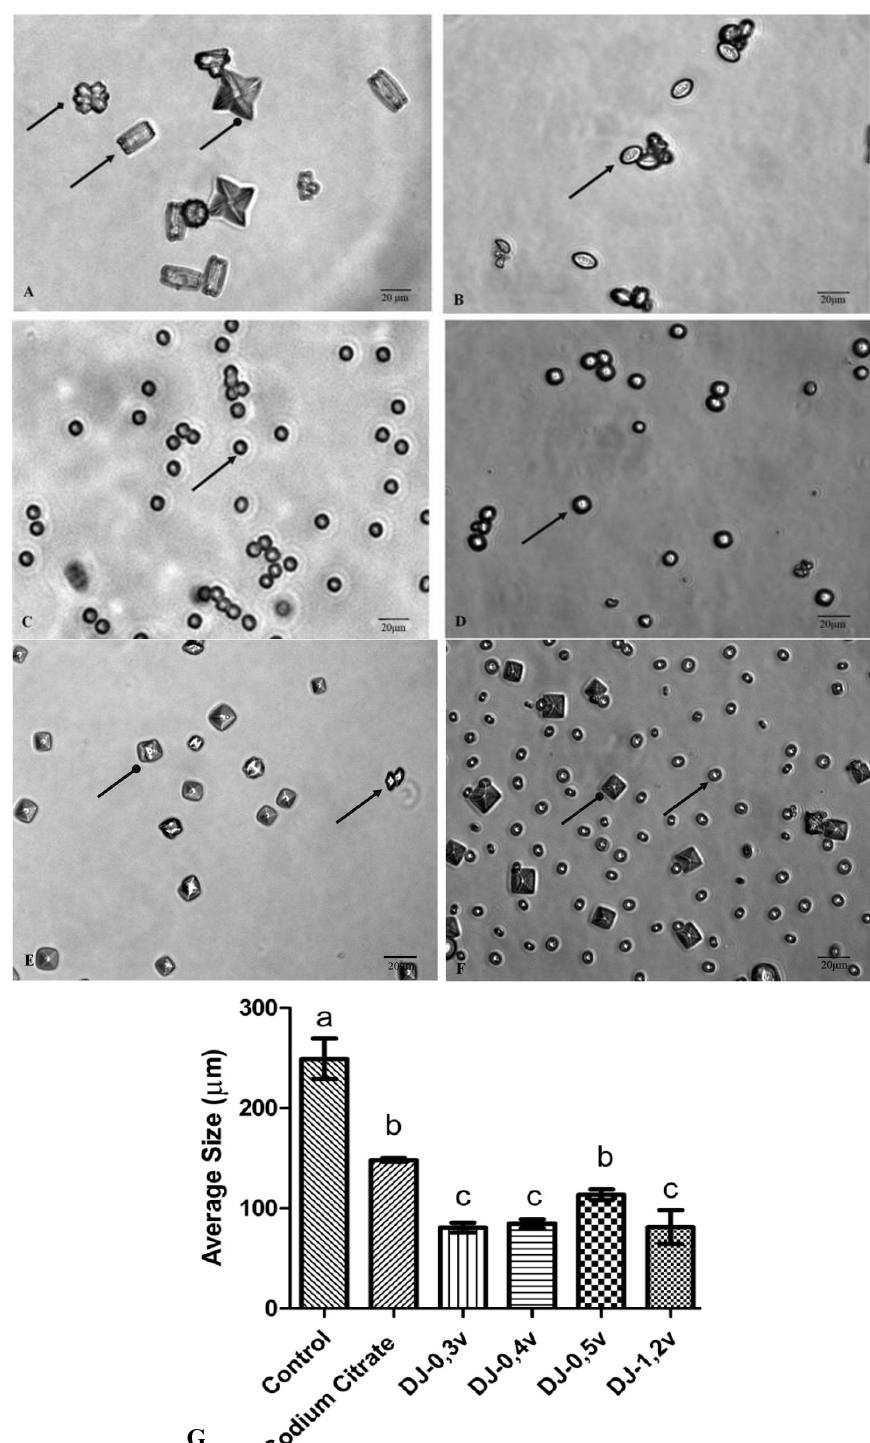
Figure 5. The CaOx crystals, observed under inversion ted microscope (60×) is formed in the meta stable solution of CaOx in the absence ( A ) and the presence of ( B ) Sodium Citrate (0.25 mM). ( C ) DJ-0.3v (0.1 mg/mL). ( D ) DJ-0.4v (0.1 mg/mL). ( E ) DJ-0.5v (0.1 mg/mL). ( F ) DJ-1.2v (0.1 mg/mL). shows COM form; shows COD form and shows COT form; ( G ) Average size of formed crystals. Different letters (a,b,c) indicate a significant difference ( p < 0.05) between the control, sodium citrate and the different polysaccharides. Scale Barr = 20 μ m.